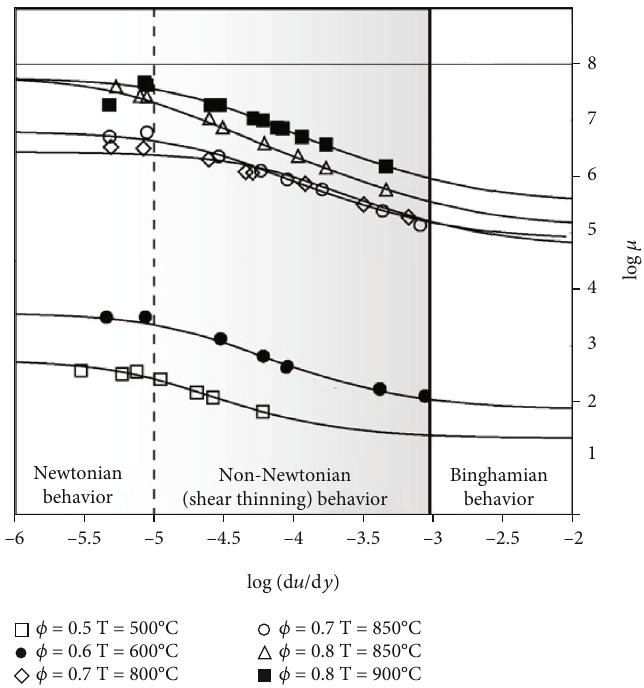
Figure 3: Flow characteristic curves of magma with di ff erent components and